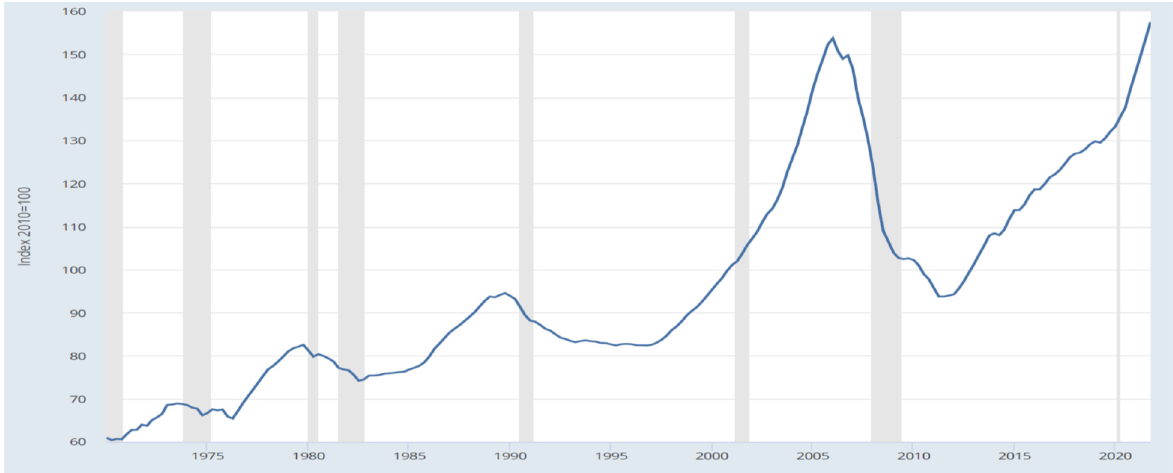
Figure 1. Real Residential Housing Prices in the US. Source: Bank of International